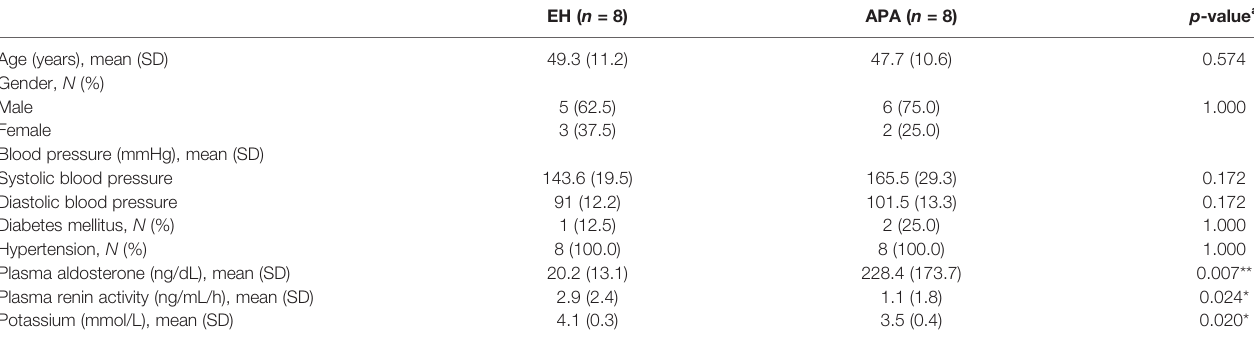
TABLE 1 | Summary statistics of essential hypertension (EH) and aldosterone-producing adenoma (APA) patients. EH ( n = 8) APA ( n =